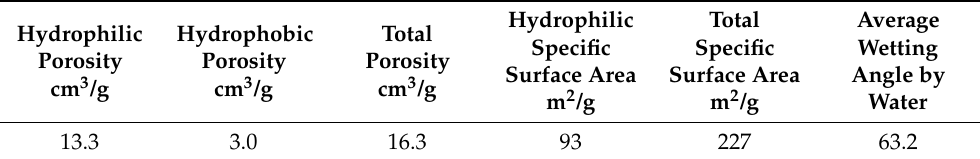
Figure 5. Results of porosimetric investigation for the rGO/TiO 2 nanocomposite containing 30% TiO 2 : ( a ) integral pore volume distribution; ( b ) differential pore volume distribution; ( c ) differential pore surface distribution; ( d ) wetting angle as a function of pore radius. Data obtained using octane (1) and water (2) as working fluids. Table 2. Main characteristics of porous structure of the rGO/TiO 2